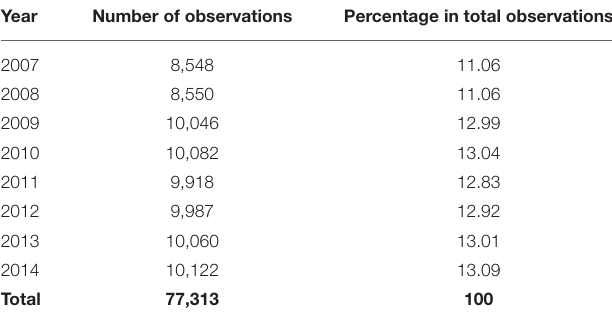
TABLE 1 | TURKSTAT HBS distribution of observations by